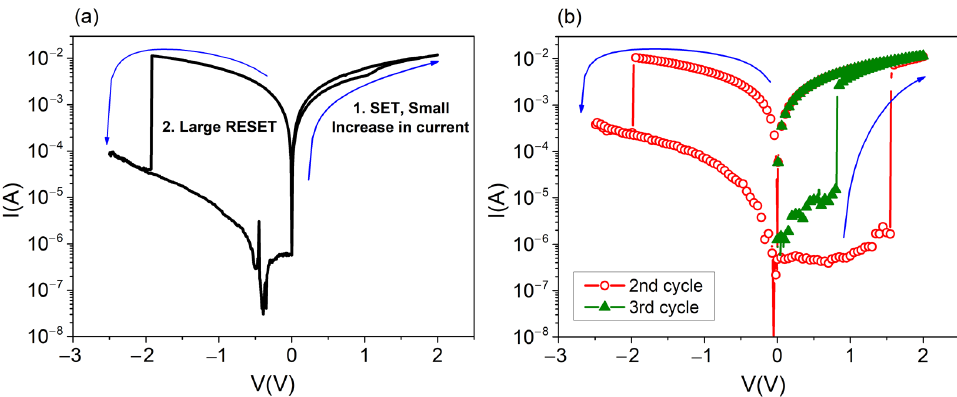
Figure 4. Resistive switching behaviour of the 8 nm film after a negative electroforming process. ( a ) 1st cycle after the electroforming. Positive voltage is applied first to initiate the RESET event and to invert the polarity. However, it does not occur (step 1), rather, a RESET can be seen when negative voltage is applied (step 2). ( b ) Two subsequent cycles, the sample still demonstrates CCW RS.